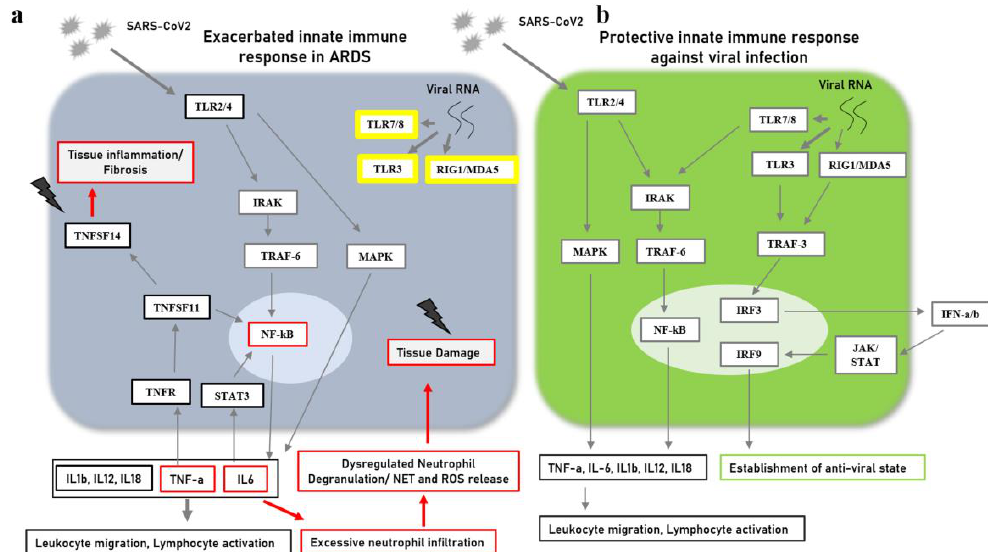
Figure 4. Signaling pathways associated with innate immune responses in the lung tissue ( a ) in ARDS and ( b ) during protective anti-viral immune responses.